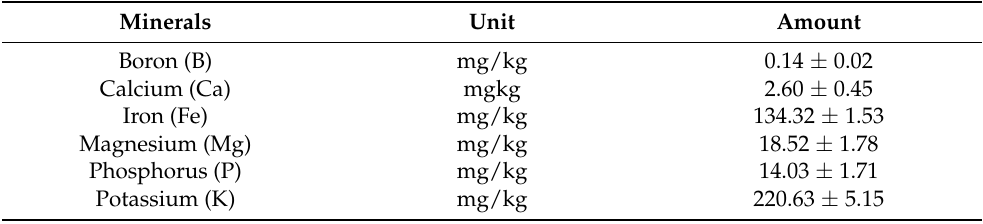
Table 7. Mineral compositions analyses in sludge generated after coagulation using FeSO 4 · 7H 2 O waste as a